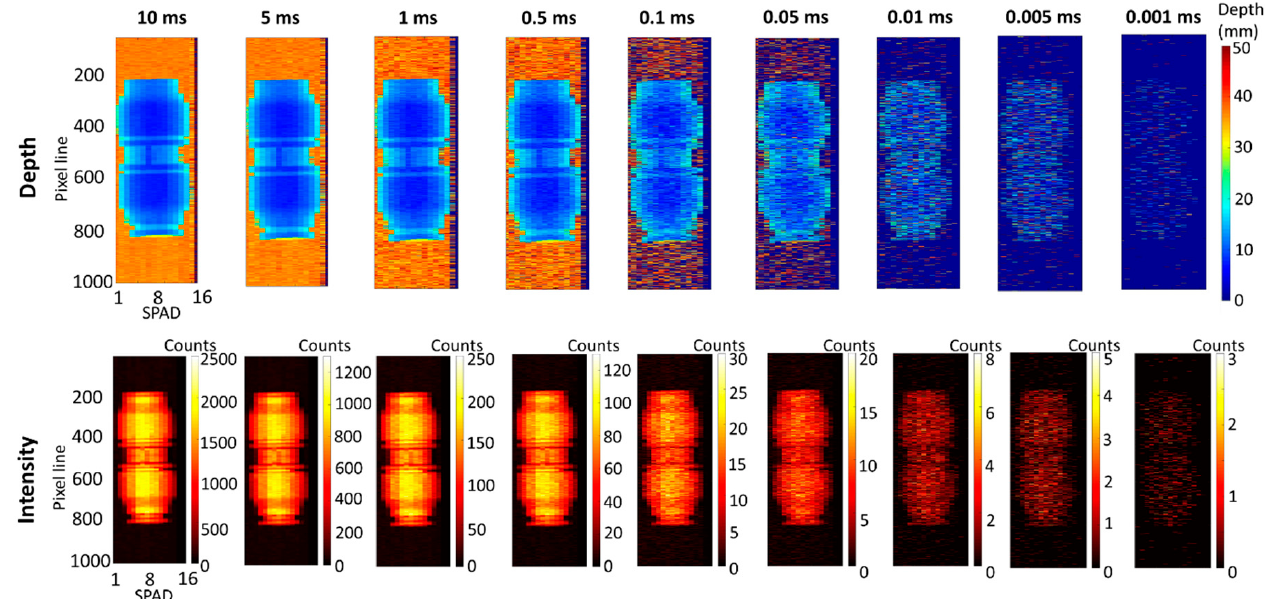
Figure 4. Depth ( top line ) and intensity ( bottom line ) profiles of the plastic pipe target in unfiltered tap water (1.2 AL). The acquisition time per line was varied by software from 10 ms to 1 µ s, and the average optical power was equivalent to 9 µ W. Under these conditions, the average target return rate for this measurement was approximately 1231 counts per pixel per 10 ms acquisition time, obtained performing the average over 8 SPAD detectors in the central part of the